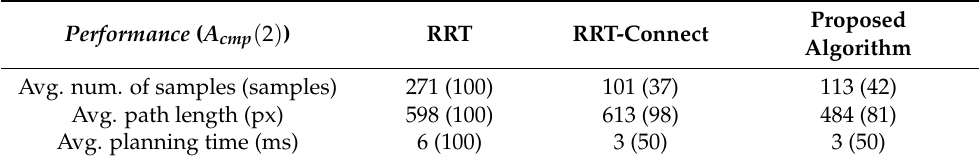
Table 3. Experimental result of Map 2 (the parentheses to the right of each value are the relative ratios based on RRT 100% ( x cmp ( 2 ) )).